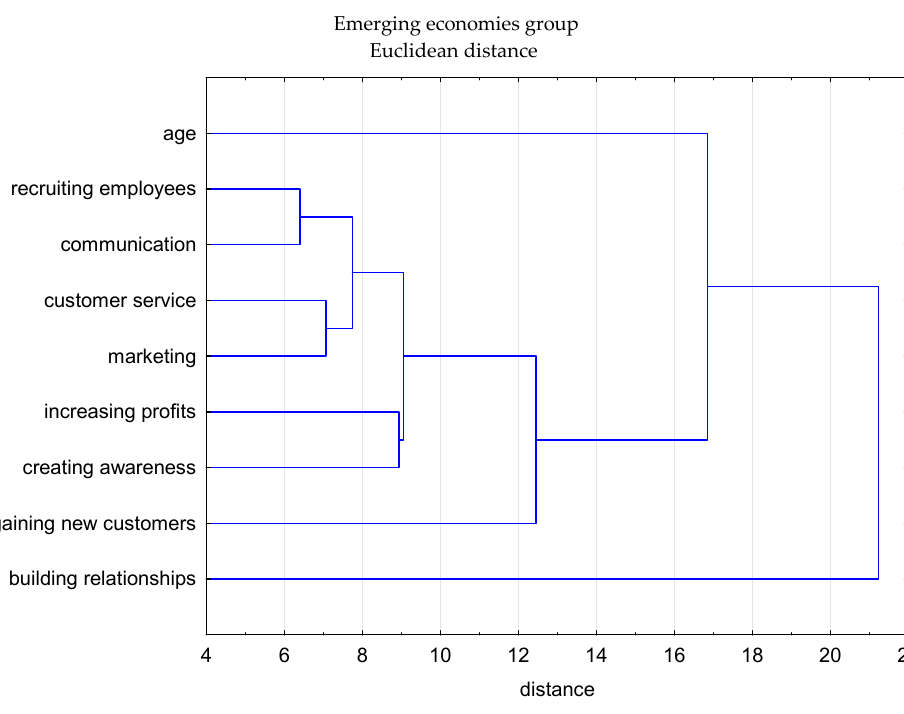
Figure 11. Hierarchical agglomeration for the emerging economies group according to Facebook purposes of usage.